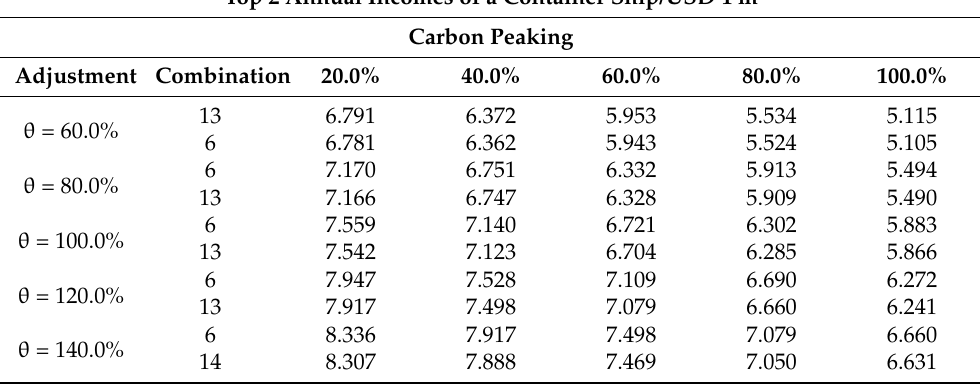
Figure 6. Annual net income for combination 13 and combination 14 when incentive levels rise.